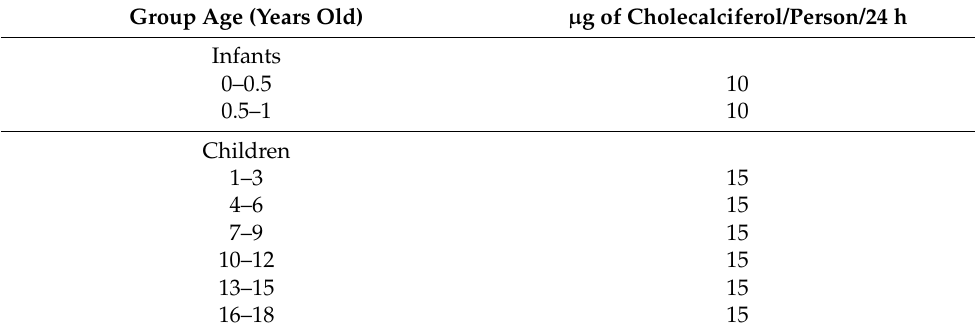
Table A3. Vitamin D—adequate intake (AI) for Polish healthy